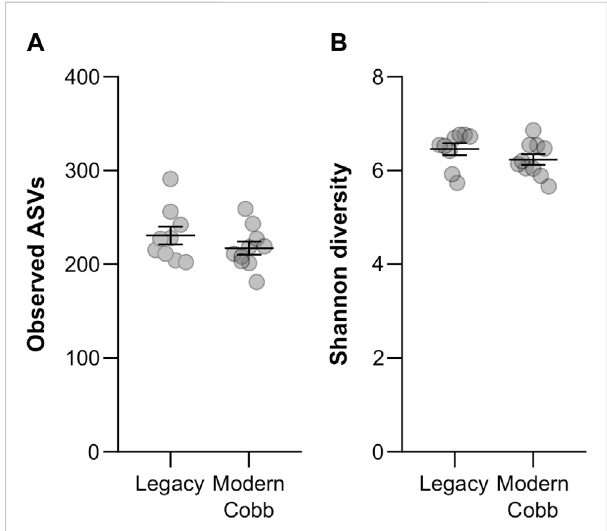
FIGURE 2 Alpha-diversity measures. Richness (A) and Shannon diversity (B) ofLegacylineandCobblineindividuals.Dataarepresentedasmean± SEM; Legacy n = 9, Cobb n = 10; Mann-Whitney test; p >